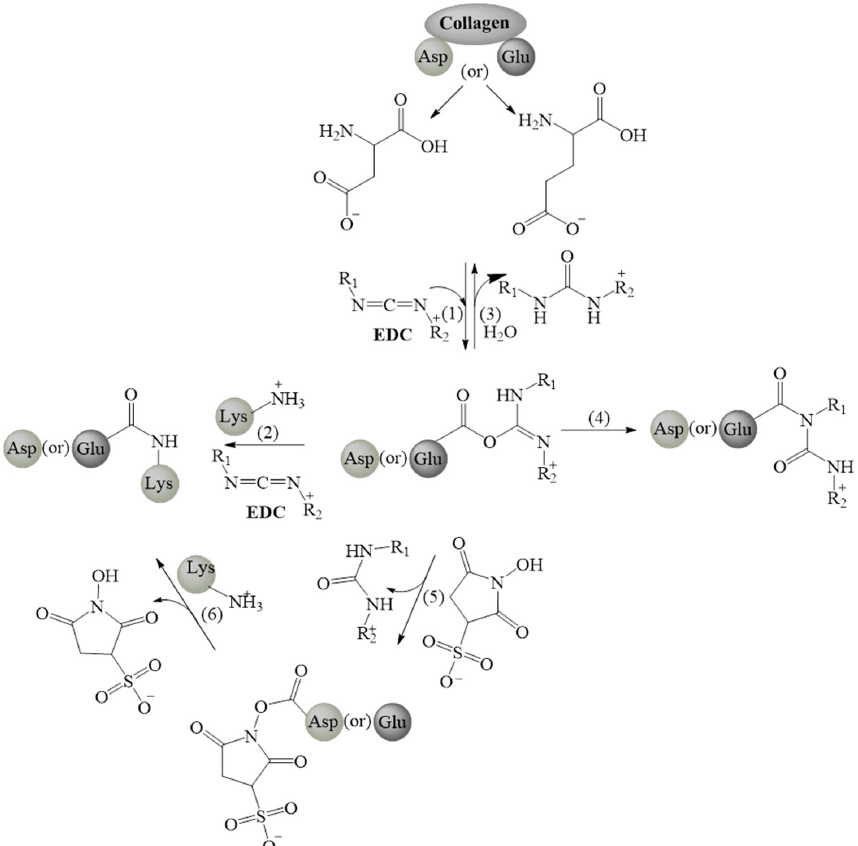
Figure 6. Scheme showing the reactions of EDC (1-Ethyl-3-(3-dimethyl aminopropyl)-carbodiimide) with carboxylates of aspartate/glutamate amino acids in collagen: (1) Attack of carboxylate oxygen of protein on electrophilic carbon of EDC; (2) An intermediate O-acylisourea reacts with the adjacent amine group of a lysine residue, forming a peptide bond; (3) O-acylisourea being unstable hydrolyses or forms comparatively stable N-acylisourea; (4) Side reaction with the addition of the positively charged group and removal of the negatively charged carboxyl group is shown; (5) The intermediate O-acylisourea reacts with sulpho-NHS (N-hydroxysuccinimide) to form another intermediate with more stability that results in high yields of favorable peptide bonds; (6) one more side reaction at the amide nitrogen of the successive residue forming cyclic